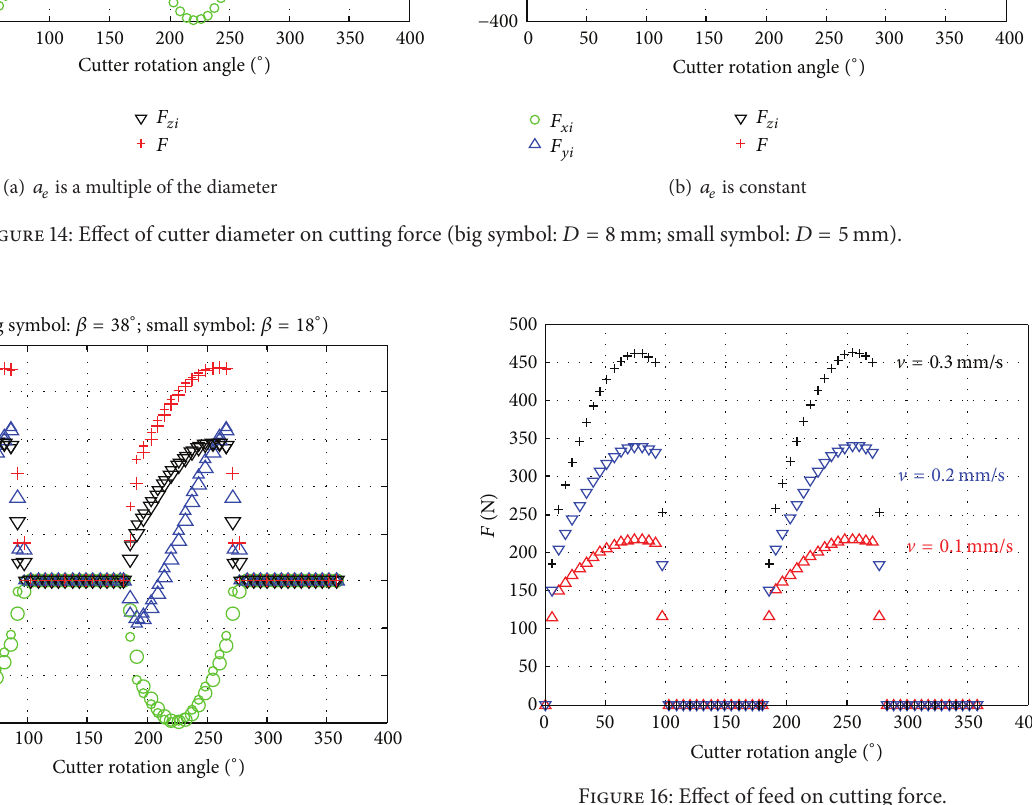
Figure 16: Effect of feed on cutting